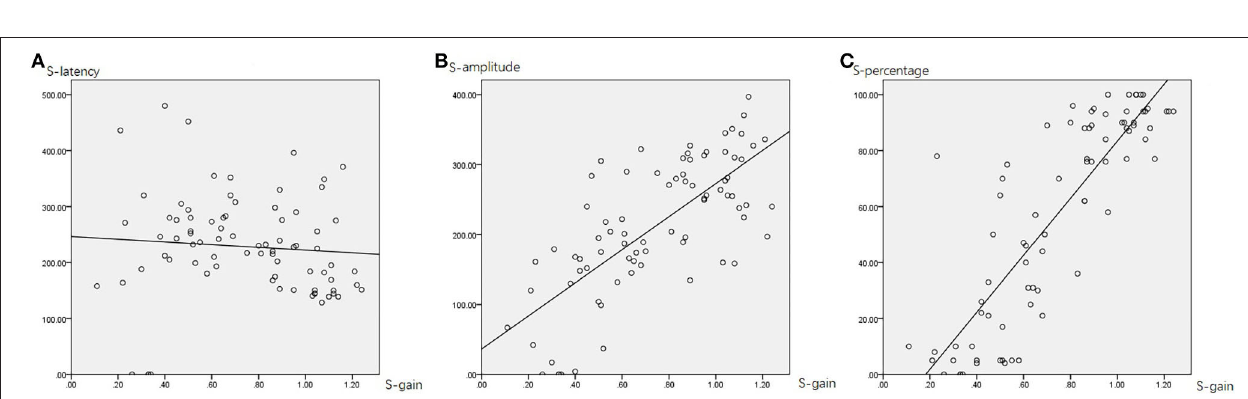
FIGURE 7 | The correlation between SHIMP gain and saccade latency (A) , amplitude (B) , and percentage (C) . The gain and latency did not correlate. Nevertheless, saccade amplitude and percentage were moderately and strongly positively correlated, respectively, with